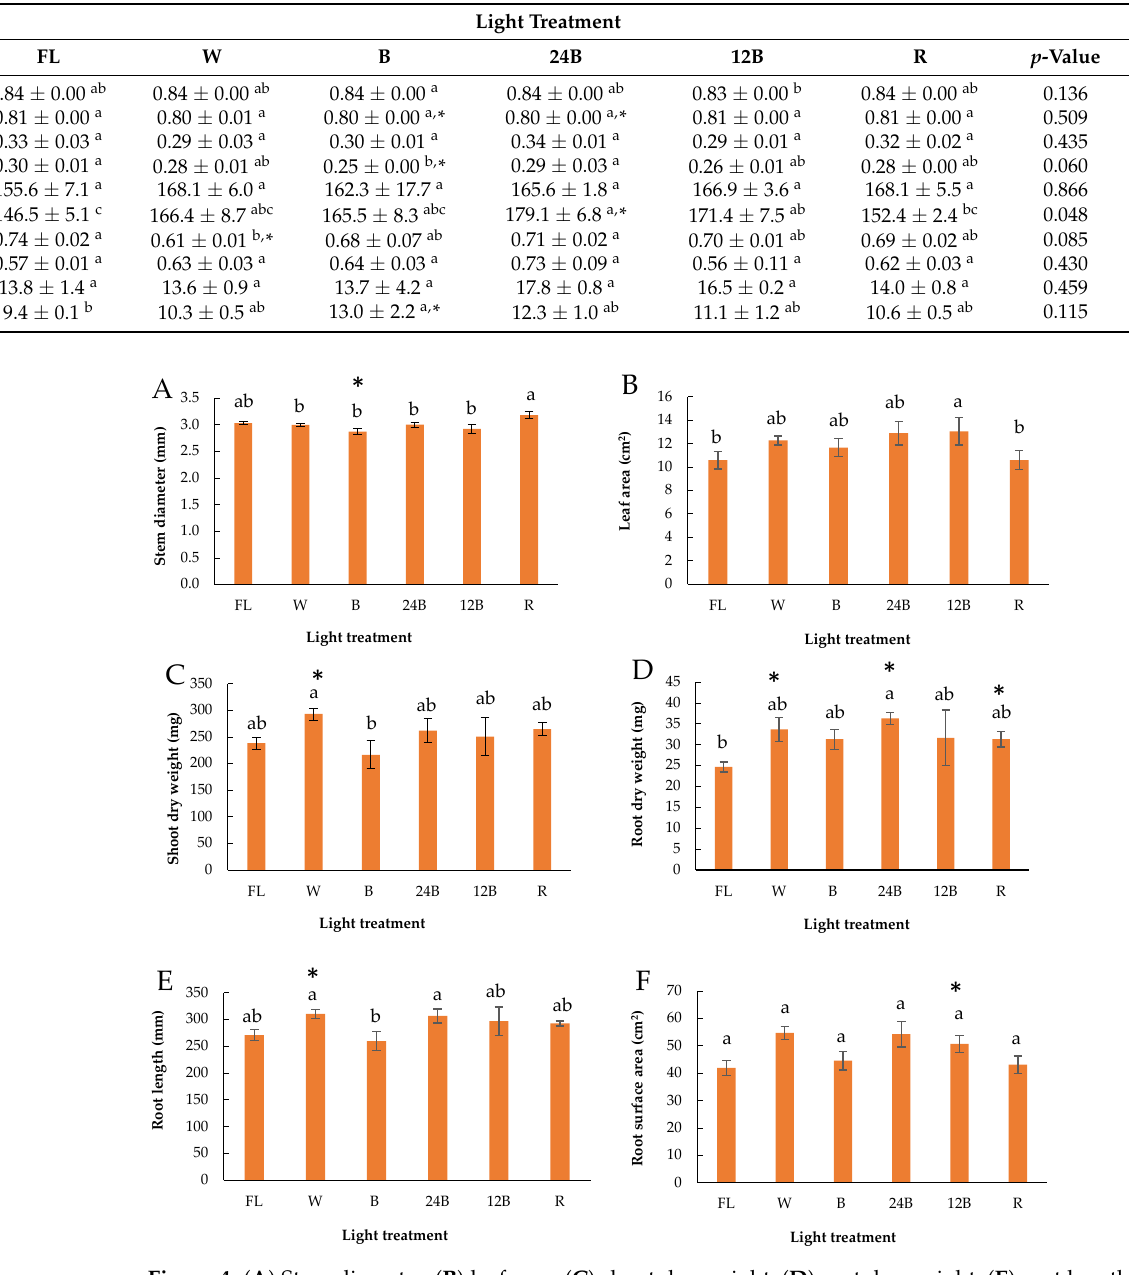
Figure 4. ( A ) Stem diameter, ( B ) leaf area, ( C ) shoot dry weight, ( D ) root dry weight, ( E ) root length and ( F ) root surface area of 6 grafted tomato seedlings per light treatment during healing, 14 days after acclimatization process plus 14 days after transplantation. Bars (±SE) followed by different letters are significantly different ( p ≤ 0.05) according to the LSD method. Bars (±SE) followed by asterisks indicate significant differences between the LED treatments and the control (FL) at p ≤ 0.05 according to t -test. FL: fluorescent lamps; W: white; B: blue; 24B: 24% blue; 12B: 12% blue; R: red.